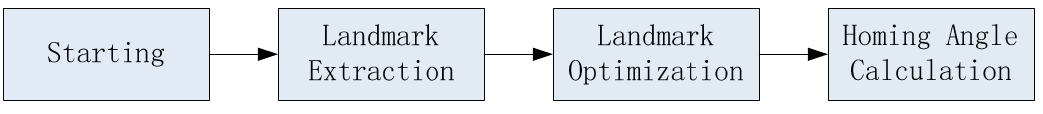
Figure 5. Flow diagram of the proposed homing